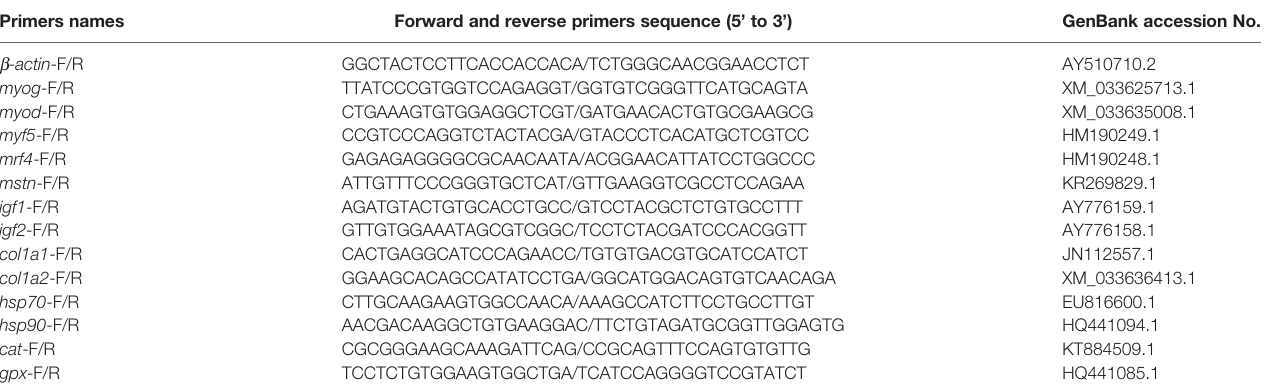
TABLE 2 | Primers used RT-qPCR.